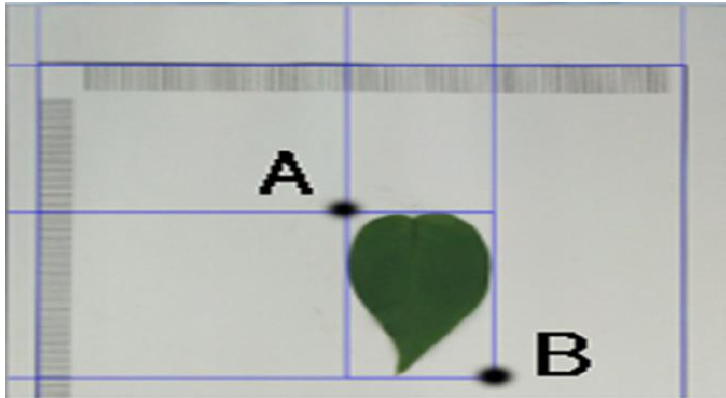
Figure 6. Positive circumscribed rectangle composed of A and B.